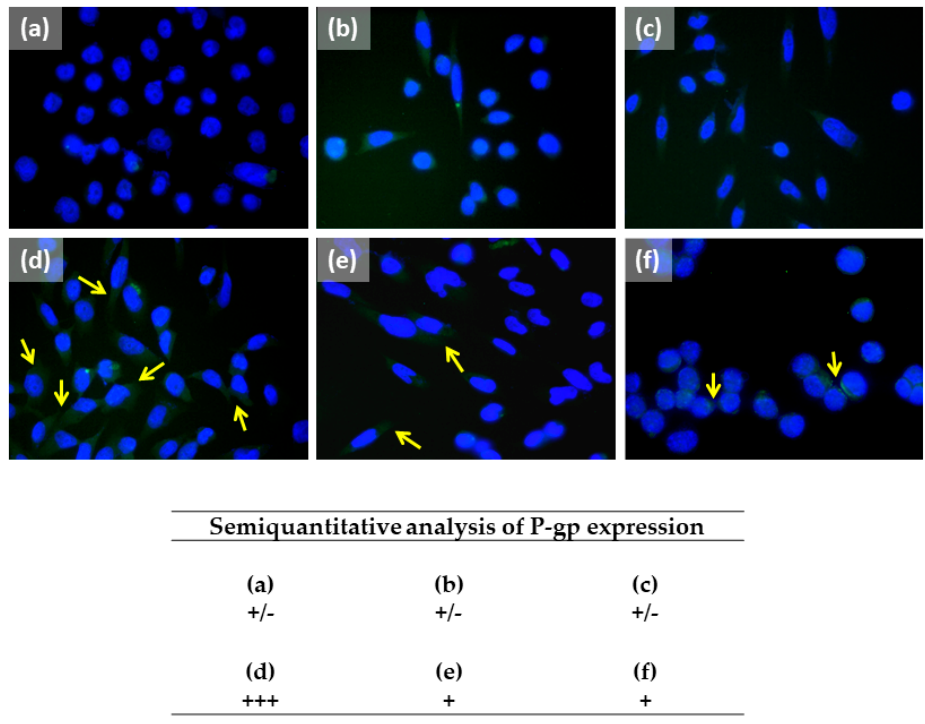
Figure 7. Representative immunofluorescence (IF) images and semiquantitative analysis of P-glycoprotein (P-gp) expression in HepG2 cells (OM 40 × ). The cells were exposed to a short treatment of 2 h with caryophyllane sesquiterpenes (50 µ M), doxorubicin (20 µ M) or their combination, then fixed by methanol. Yellow arrows indicate the presence of P-gp protein. ( a ) Vehicle control (EtOH 1 % v / v ). ( b ) β -Caryophyllene. ( c ) β -Caryophyllene oxide. ( d ) Doxorubicin. ( e ) Combination of doxorubicin and β -caryophyllene. ( f ) Combination of doxorubicin and β -caryophyllene oxide. The semiquantitative analysis has been carried out (four fields for each treatment) using a previous published grading system [31]: 0%–5% = negative; 6%–10% = +/ − ; 11%–30% = + ; 31%–60% = ++ ; > 61% = +++.